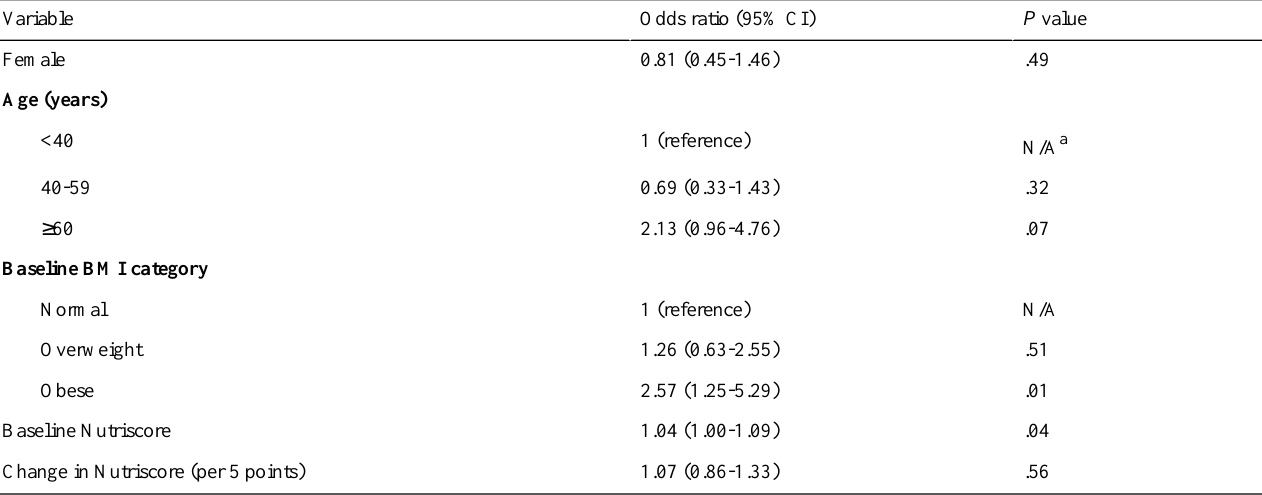
Table 2. Association between predictors and the likelihood of changing the dyslipidemia status to normal in multivariate logistic regression models.